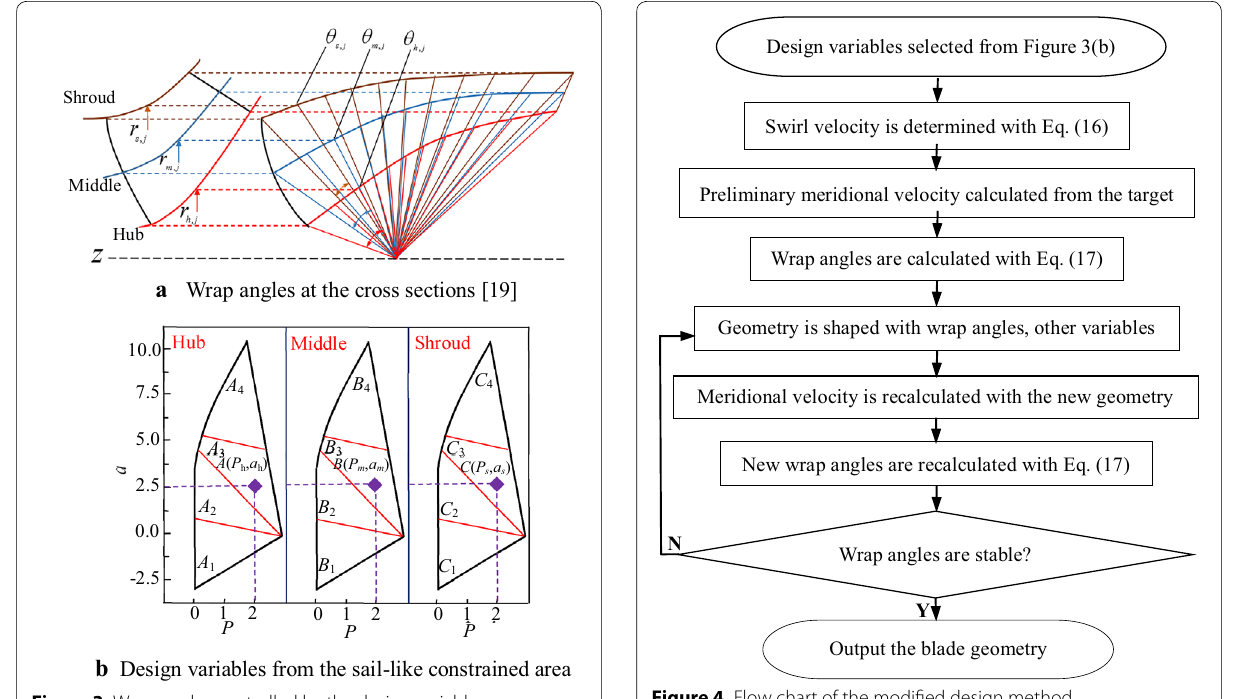
Figure 3 Wrap angles controlled by the design variables